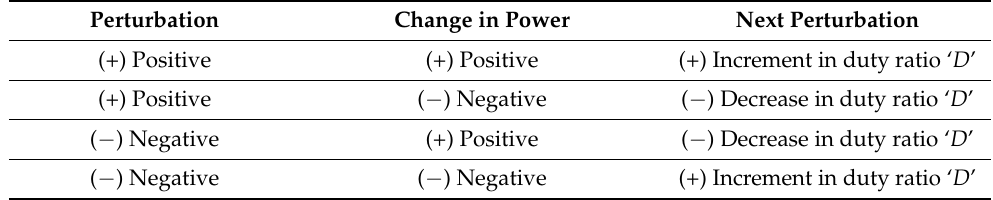
Figure 3. Power characteristic of SPV in perspective with P&O MPPT [23]. Table 1. Methodology of P&O technique